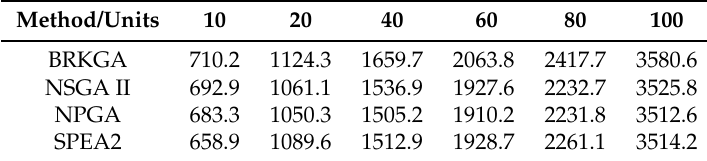
Table 14. Extent average measures over 10 optimization runs.